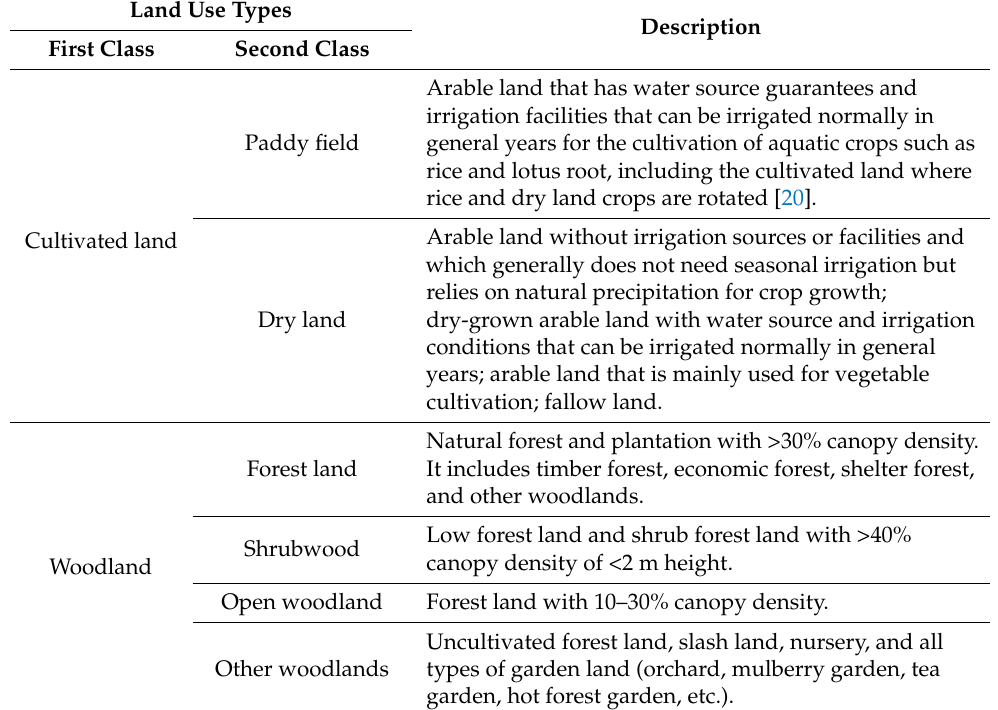
Table 1. Land use classification and its specific